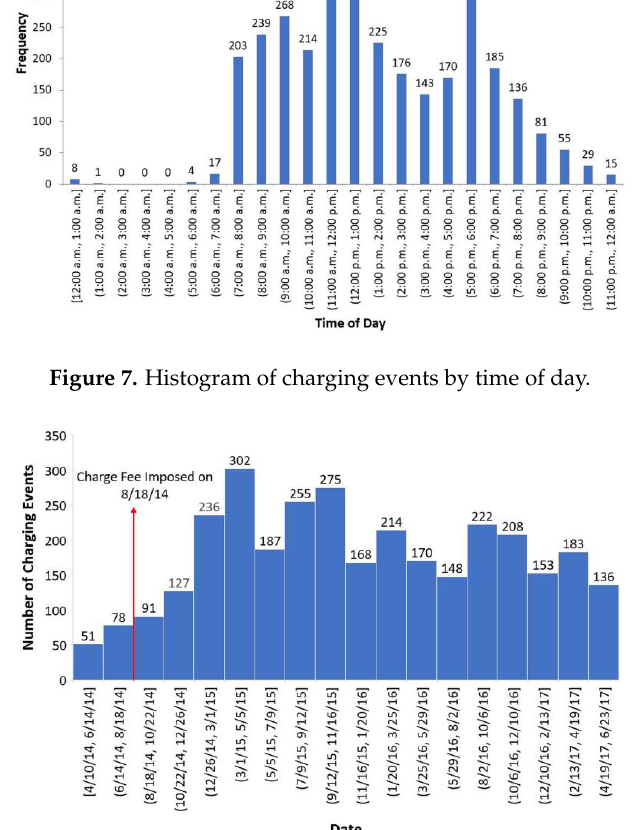
Figure 8. Distribution of charging events over time. Onset of electricity fee indicated with arrow.